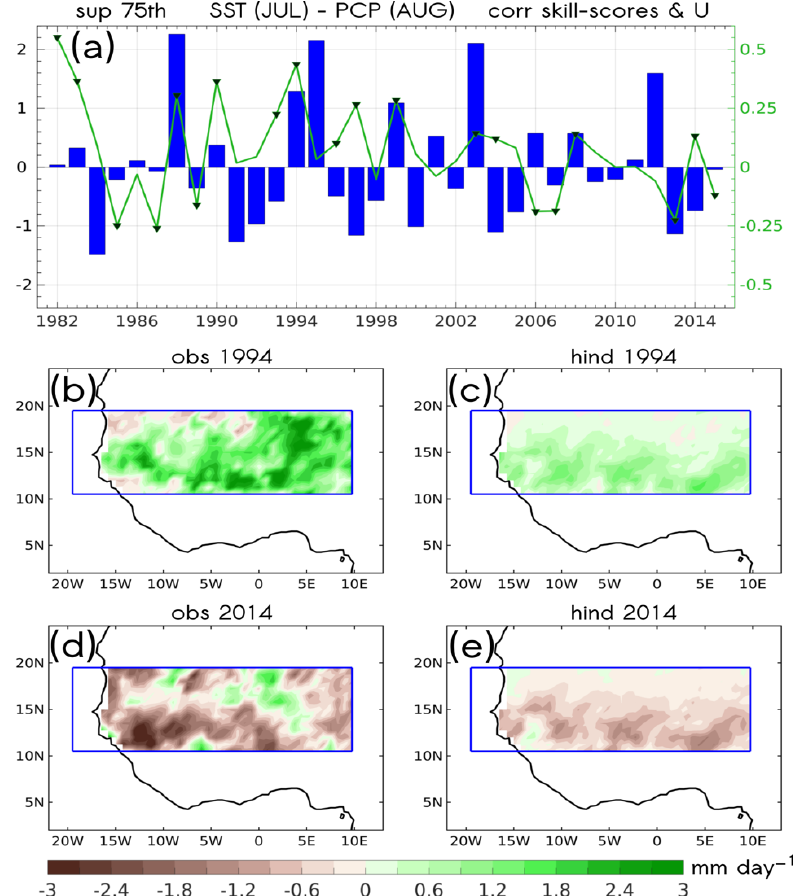
Figure 7. Skill-score validation time series between the hindcasts and observations corresponding to the leading MCA mode between the Eastern Mediterranean SSTA (16°–38° E; 30°–40° N) in JUL (lag 1) and the anomalous Sahel (20° W–20° E; 10°–20° N) rainfall above the 75th percentile in AUG. ( a ) Validation time series (green line) in terms of Pearson correlation coefficients between maps of the observations and hindcasts for the regions of positive significant spatial skill scores (see Figure 2c). Significant values are denoted by green shaded triangles. Statistical significance is set at the 95% (0.05) level using the Monte Carlo method (1000 permutations). Time series expansion coefficients for SST (U; blue bars) denote the weight of the SSTA mode for each year. ( b , c ) Comparison between ( b ) observations and ( c ) hindcast for the 1994 case study. ( d , e ) Comparison between ( d ) observations and ( e ) hindcast for the 2014 case study.